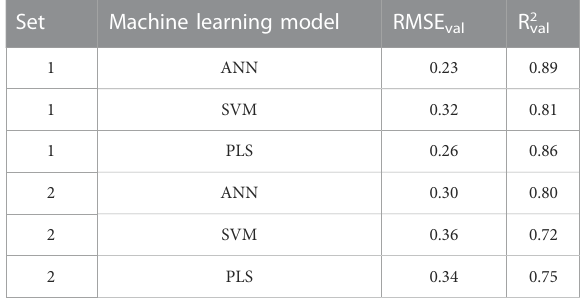
TABLE 5 Evaluation of predictive performance of the different machine learning models.